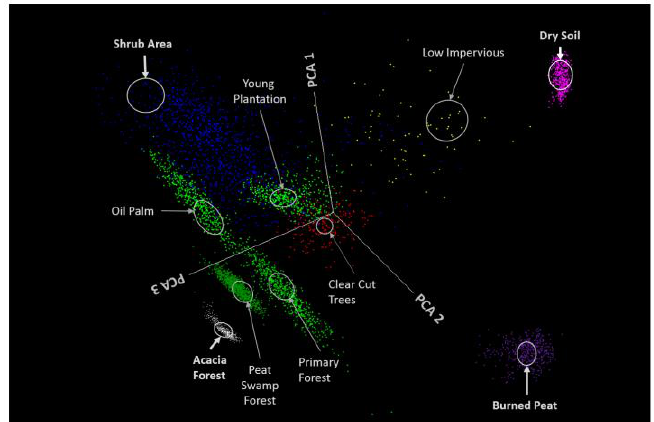
Figure 4. Three dimensional visualization model of ten land cover classes based on Pelalawan fraction